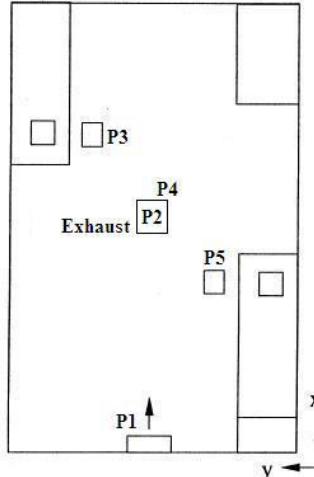
Figure 7. Locations of five recording points in the computing domain, top view.